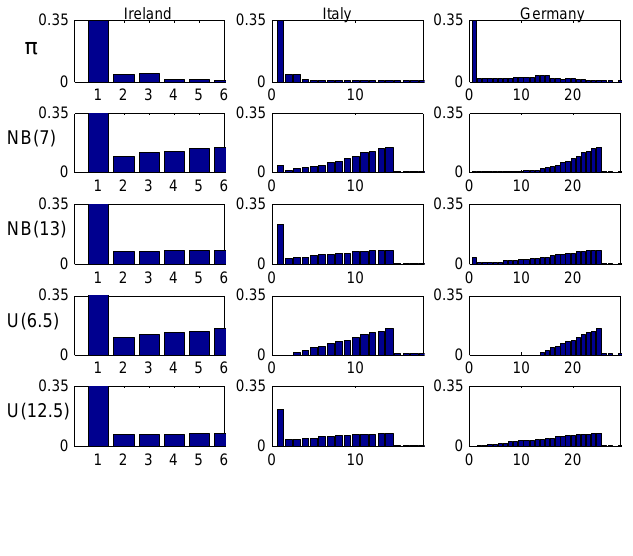
Figure 15. Population averaged age-corrected distributions: population mean